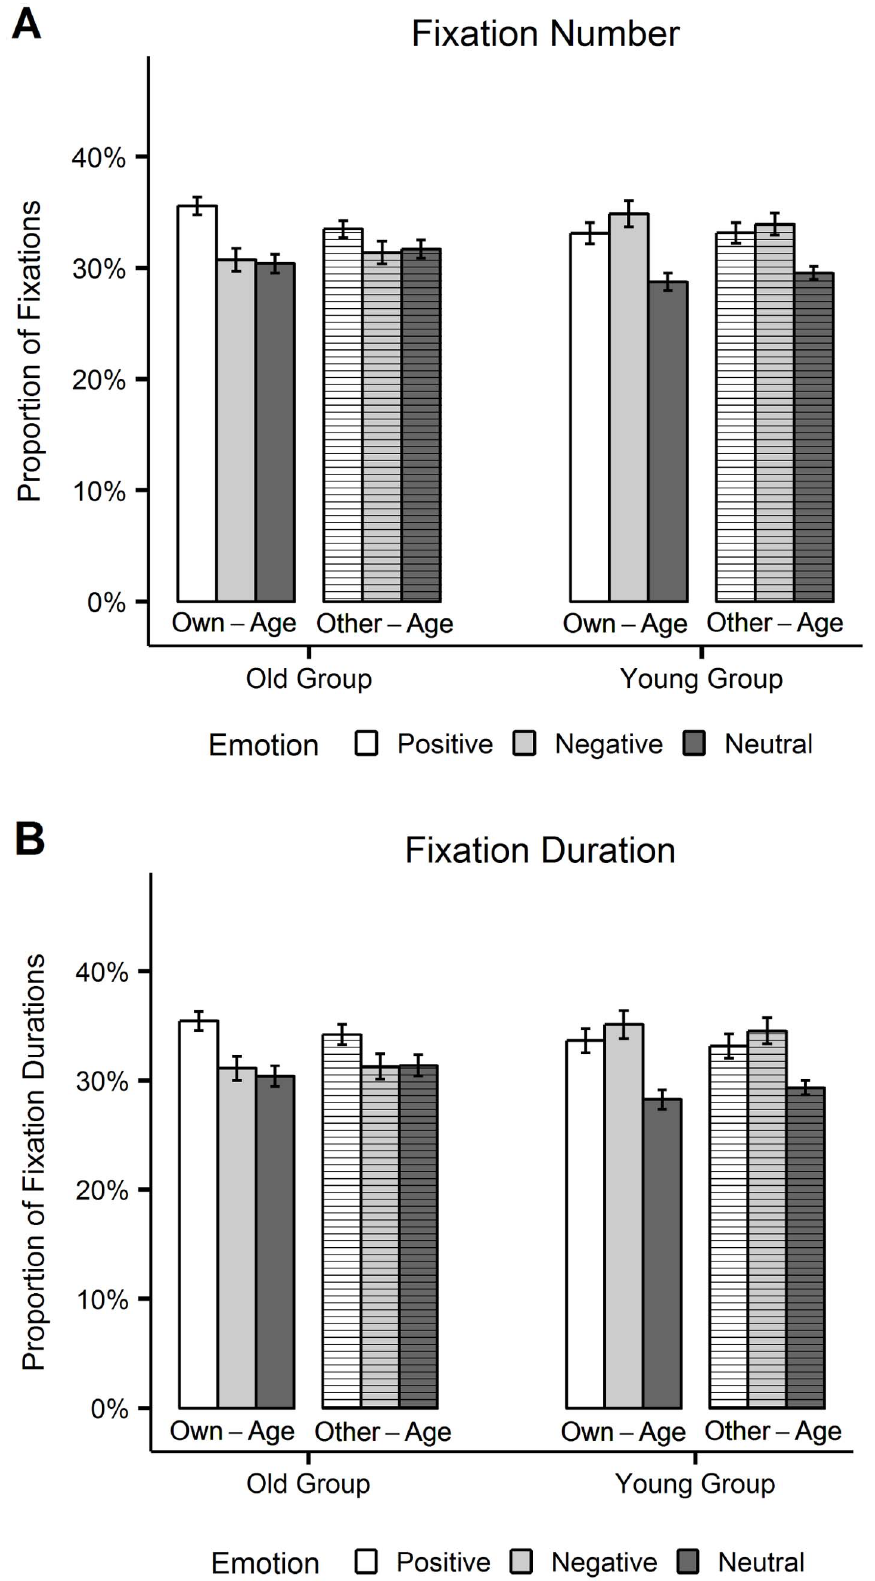
Figure 3. Eyetracking data. Proportions of fixations (A) and fixation durations (B) on positive, negative and neutral own-age and other-age stimuli, plotted separately for each age-group. Error bars represent standard errors of the mean.